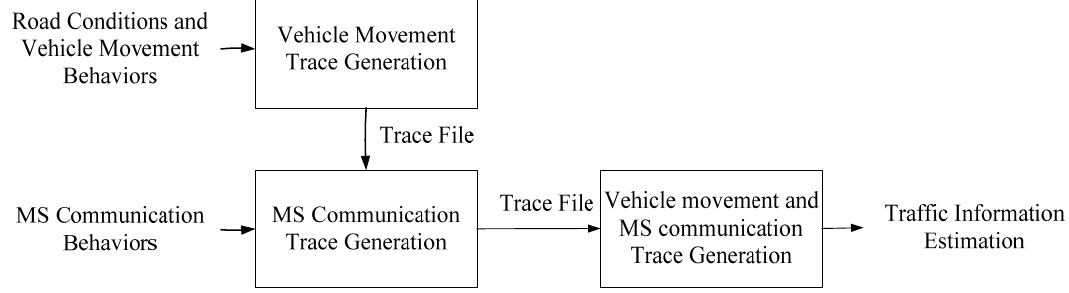
Figure 6. Trace-driven simulation for the traffic information estimations.